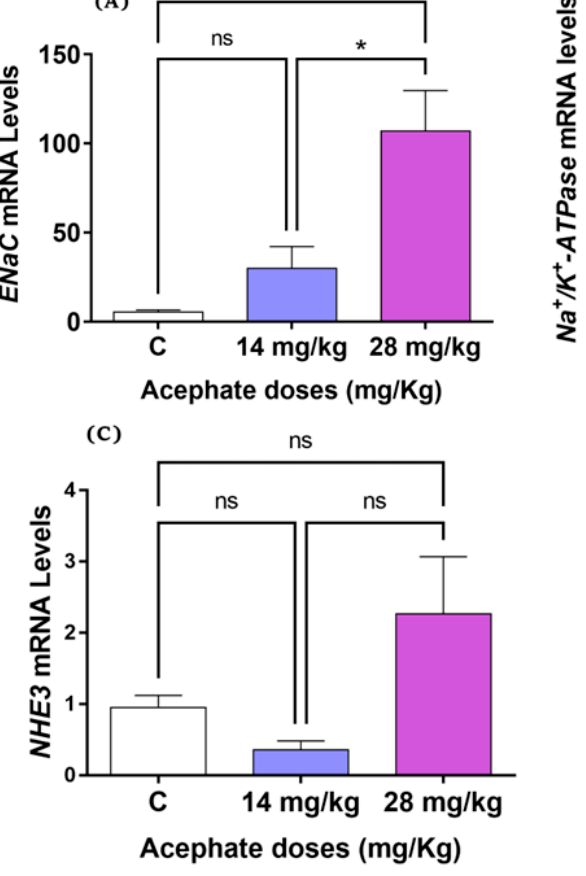
Figure 5. Effect of prenatal acephate exposure on the expression of genes involved in renal toxicity in adult rat offspring. The mRNA expression levels of the genes ENaC ( A ), Na + /K + -ATPase ( B ), and NHE3 ( C ) were analyzed by RT-PCR. All data are expressed as mean ± SD. * p < 0.05; ** p < 0.01; *** p < 0.001; **** p < 0.0001, ns: nonsignificant. ENaC, epithelial sodium channel; NHE3, Na + /H + Exchanger 3 ( n = 8).